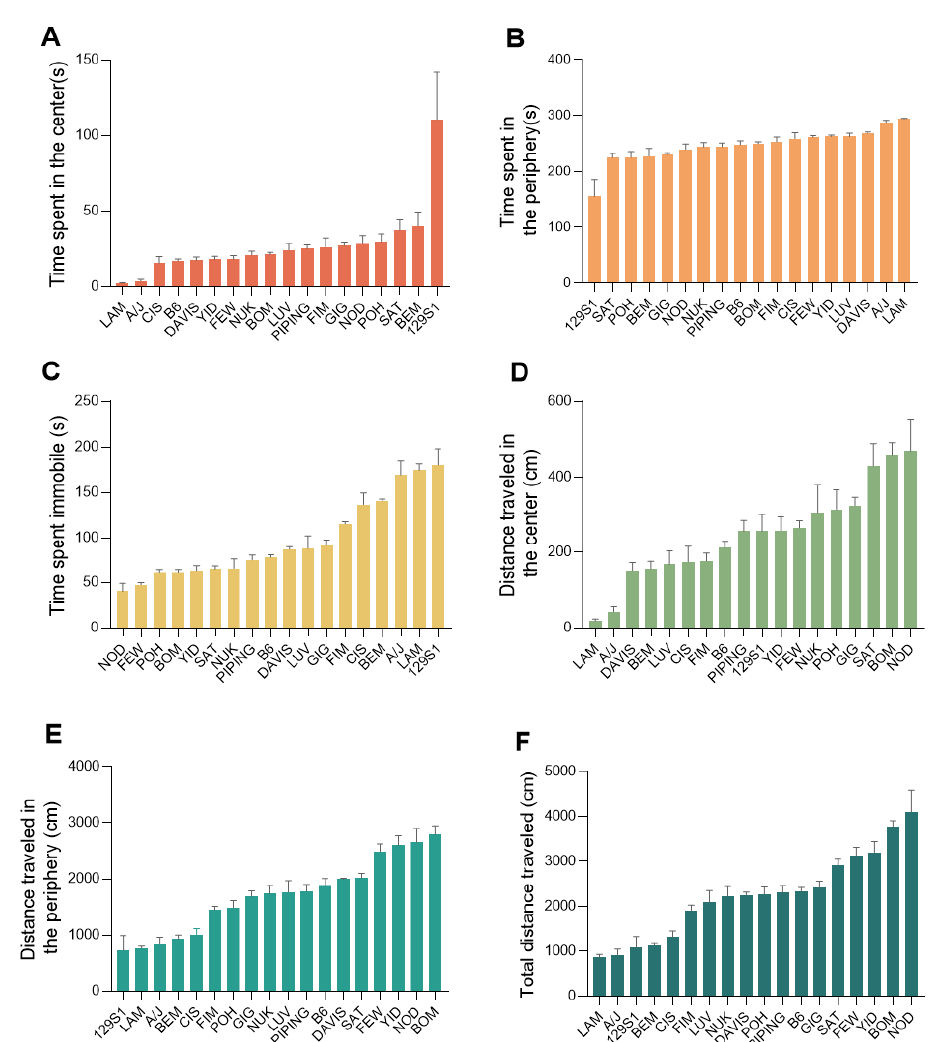
Figure 2. Phenotypic diversity in open field traits among the CC population. ( A ) Time spent in the center of an open field during a 5 min test period (s). ( B ) Time spent in the periphery of an open field during a 5 min test period (s). ( C ) Time spent immobile of an open field during a 5 min test period (s). ( D ) Distance traveled in the center of an open field during 5 min test period (s). ( E ) Distance traveled in the periphery of an open field during 5 min test period (s). ( F ) Total distance traveled in an open field during a 5 min test period (cm). Plots are expressed as mean ± SEM, with CC lines ordered along the x -axis by mean per phenotype. (( A – F ) one-way ANOVA p < 0.001).